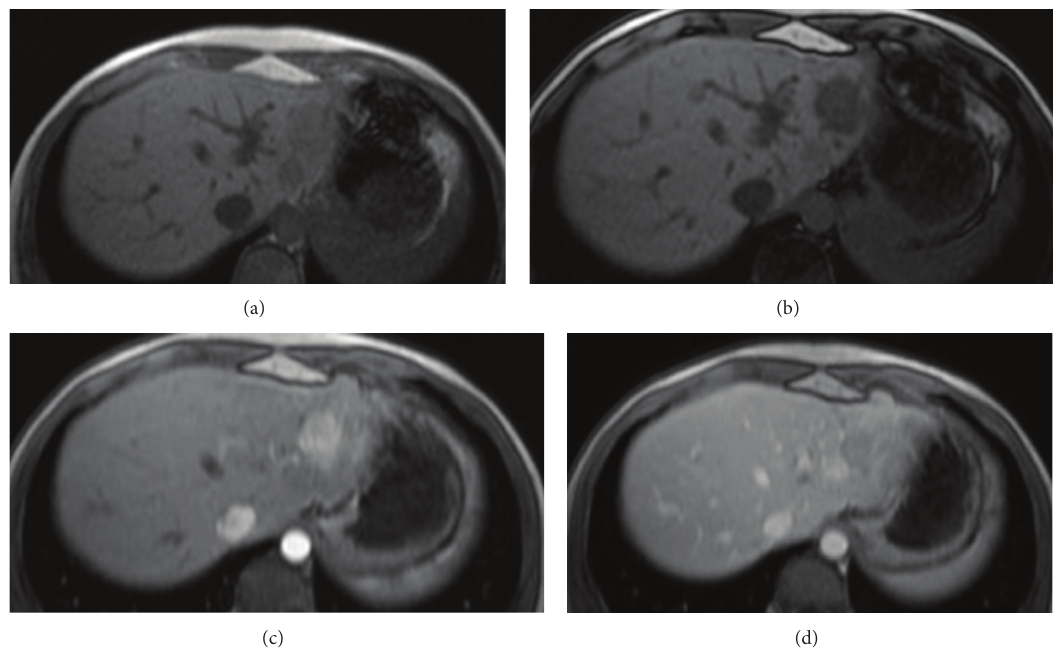
Figure 4: Adenomatosis related to HNF1- 𝛼 germline mutation aspect on MRI in a 14-year-old girl: (a) and (b): T1 WI with chemical shift shows two lesions in the left lobe of the liver with drop of the signal of the largest lesion on the out-phase sequence that reveals the presence of fat in the tumor. (c) and (d): T1 WI after contrast injection shows early arterial enhancement of the largest lesion with washout in the late portal phase.